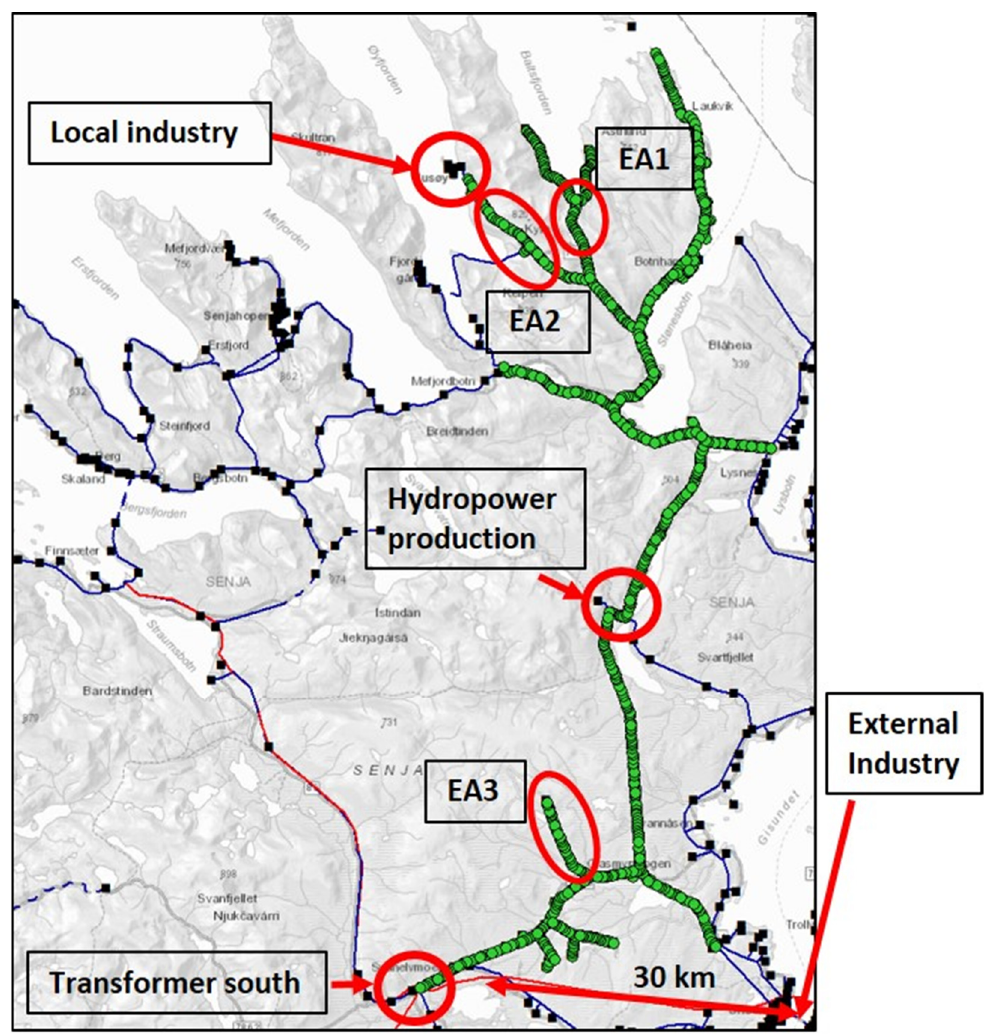
Figure 5. The SVAN22LY1 grid with locations for all the variables included for statistical analyses. The figure shows the SVAN22LY power grid marked by the green dots that represent the positions of the utility poles. Each of the EAs are highlighted. EA1 and EA2 are in the northern part of the grid, and EA3 is in the southern part. The electrical transformer station in the south is located approximately 30 km away from the external industry. The hydropower station is in the middle of the power grid and supports the communities with electricity. The hydropower plant has a capacity of 5.3 MW and has an average yearly electricity generation of 28.1 GWh. The largest industry connected to SVAN22LY1 is in the northernmost part of the grid.